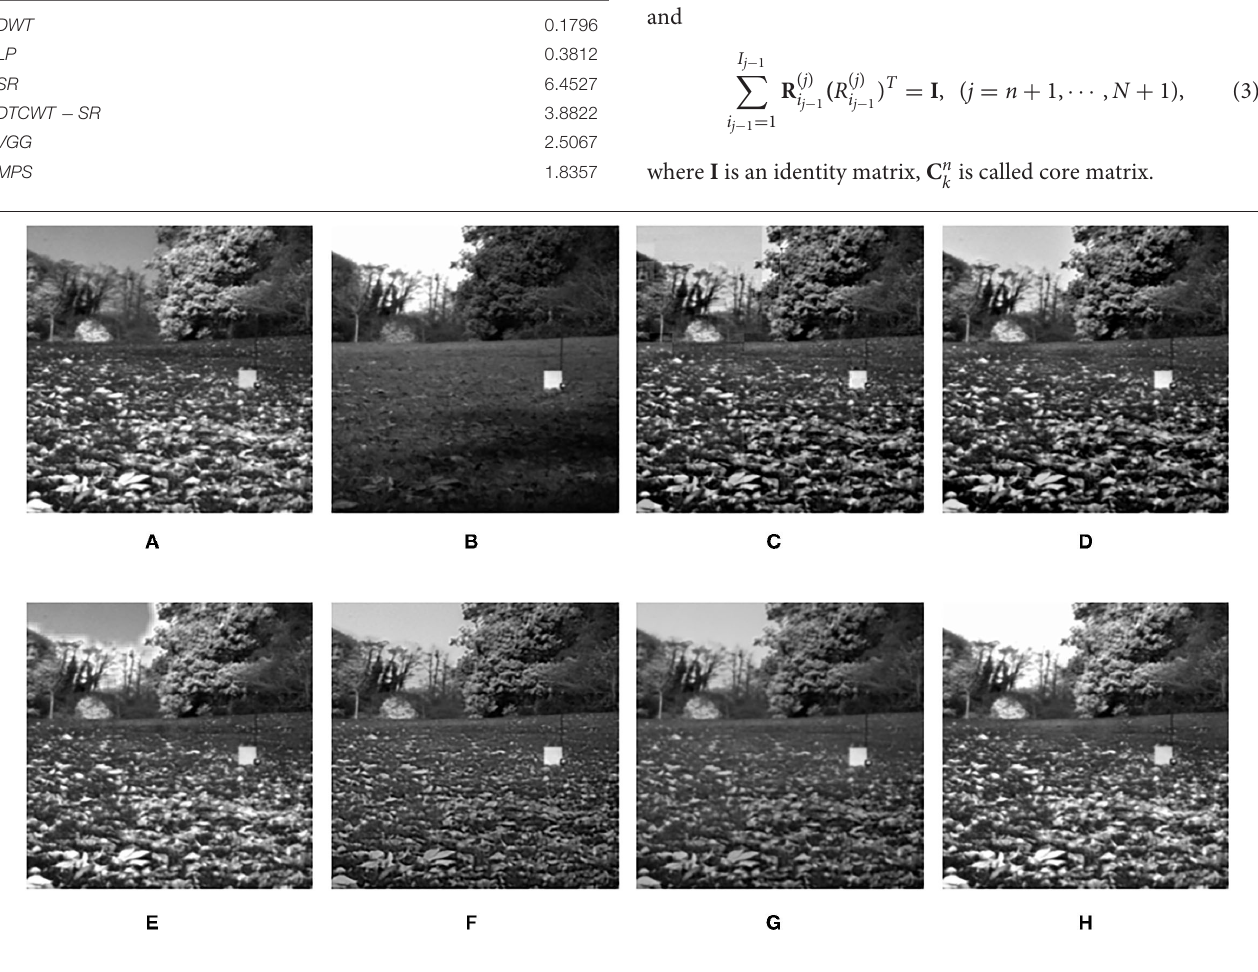
FIGURE 7 | Comparison experimental results of infrared and visible images. (A) original figure (infrared image); (B) original figure (visible image); (C) discrete wavelet transform (DWT); (D) laplacian pyramid (LP); (E) sparse representation (SR); (F) Dual-tree complex wavelet transform-sparse representation (DTCWT-SR); (G) VGG; (H) Matrix product state